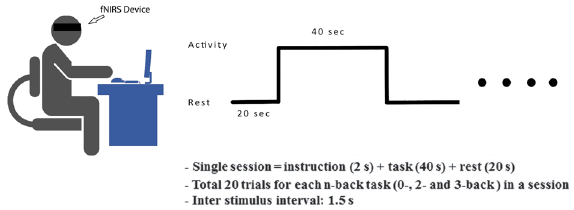
Figure 2. The experimental paradigm for data